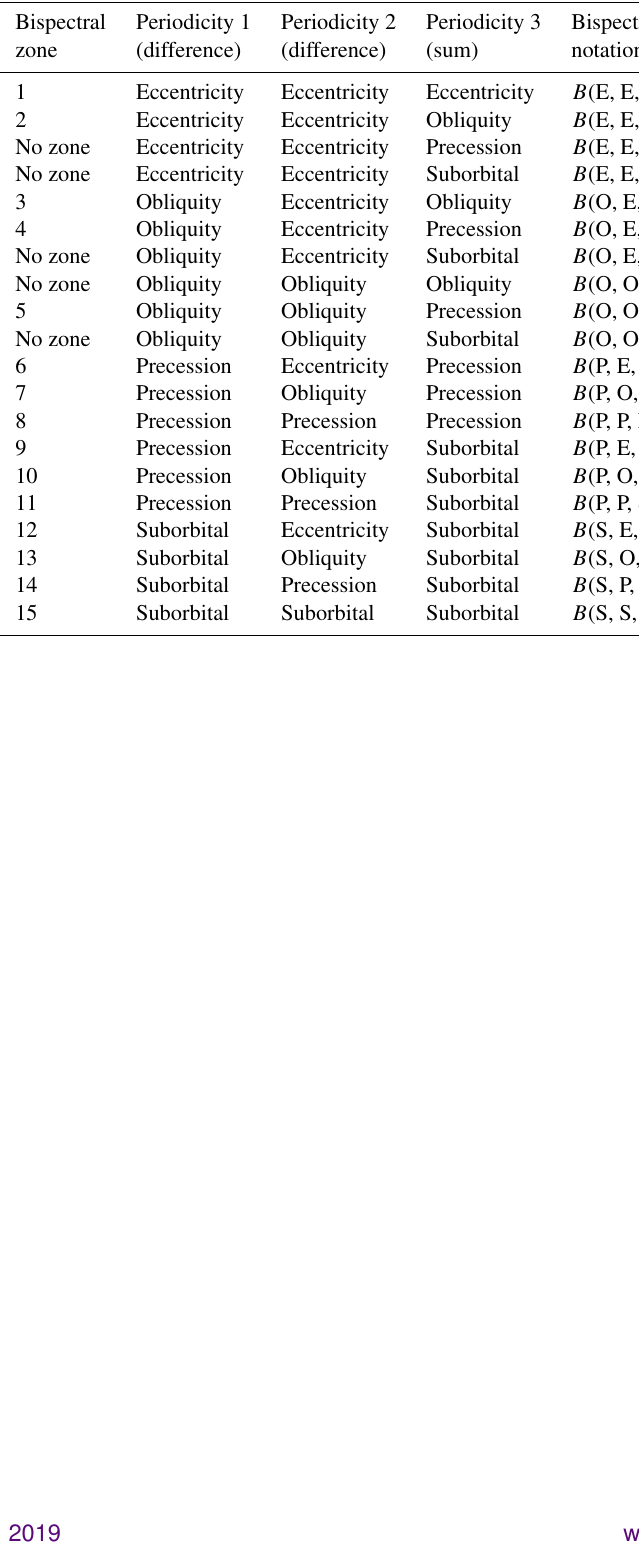
Table A1. Bispectral zones defined in this study. These zones correspond to Fig. 3. The boundaries between the climate cycle zones are (arbitrarily) defined at periodicities of ∼ 56 . 2, ∼ 28 . 1, and 12.5kyr (i.e. frequencies of 17.8, 35.6, and 80.0Myr − 1